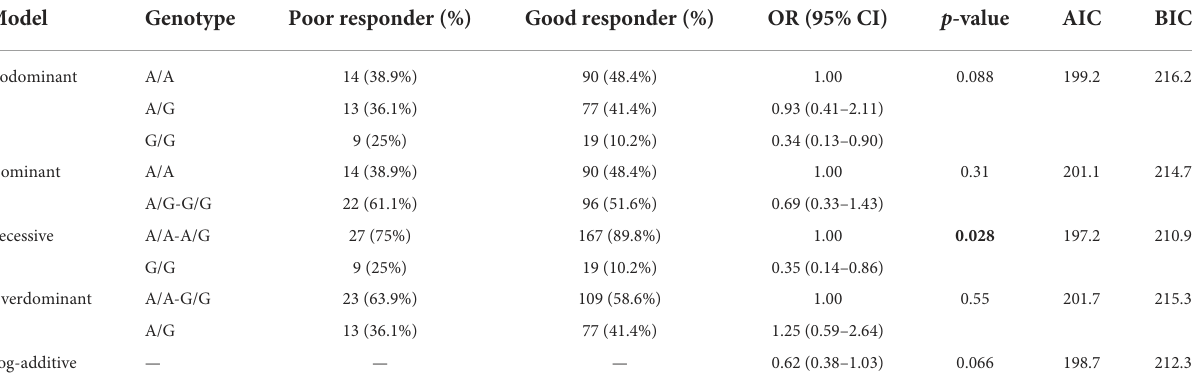
TABLE 6 Logistic regression analysis of associations between the genotypes of NPY rs5573 with antipsychotic response.